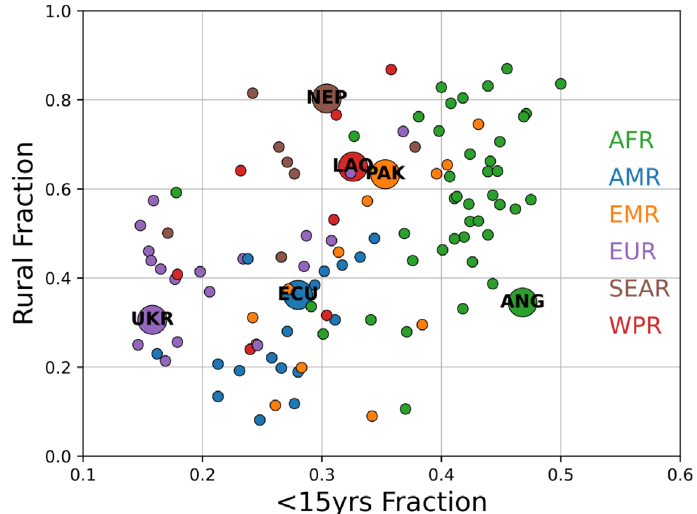
Figure 2. Variation in population fraction younger than 15yrs and rural population fraction in low- and middle-income countries for all six WHO regions. Representative country contexts examined in this study are annotated using larger markers. Size is only intended to highlight marker